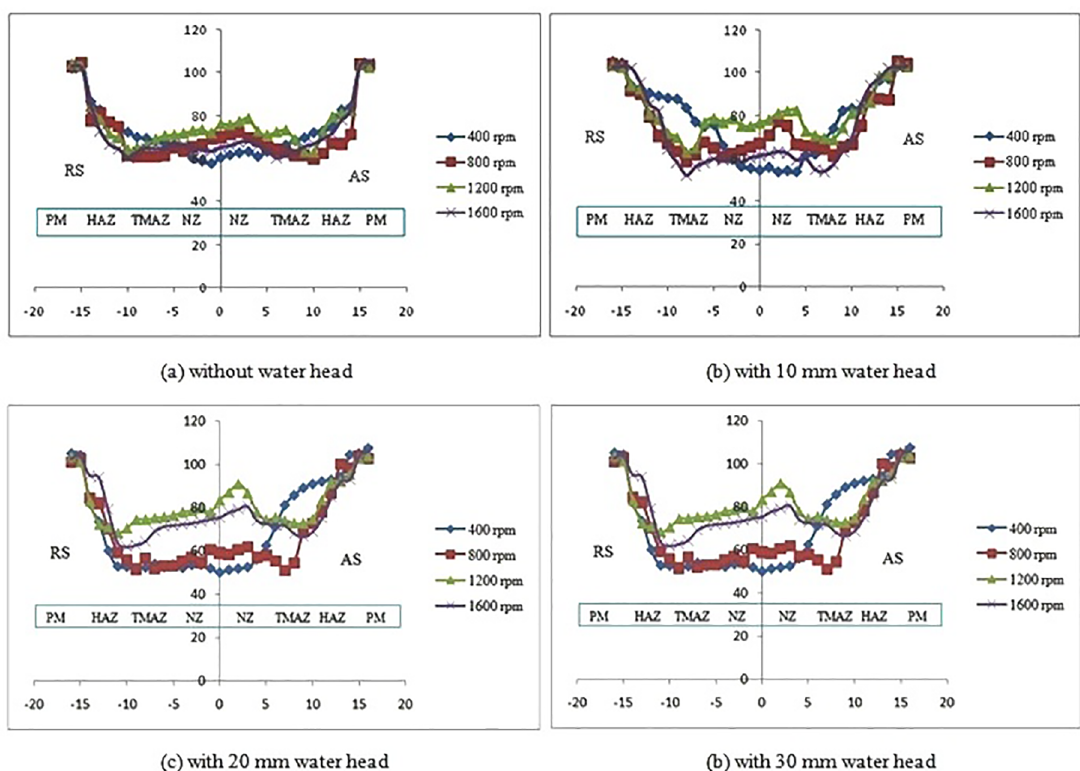
Figure 10 . Hardness profiles (a) without water head (b) with 10 mm water head (c) with 20 mm water head (d) with 30 mm water